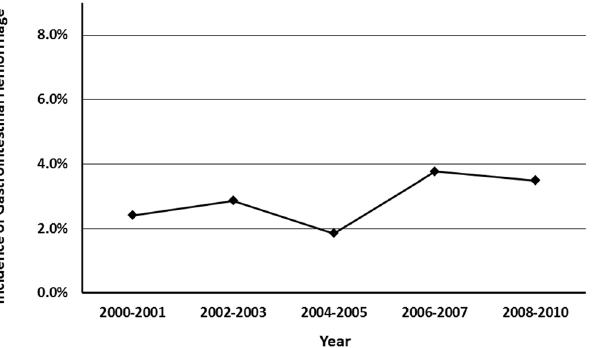
Figure 1. Prevalence of gastrointestinal hemorrhage after spontaneous SAH over